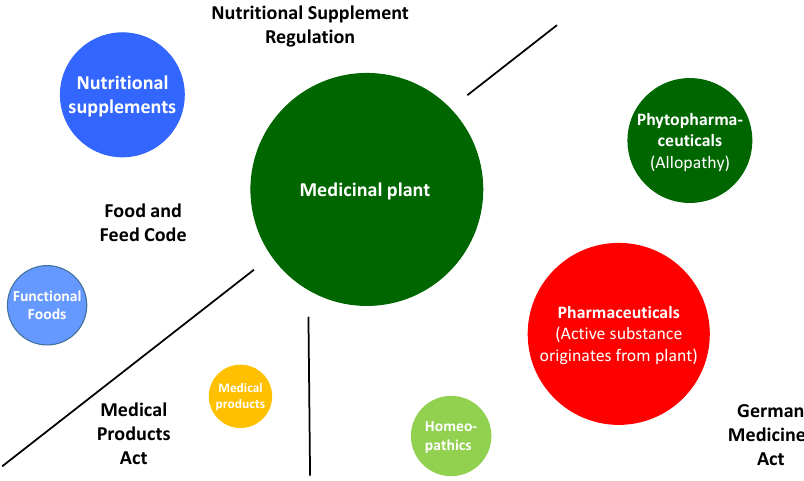
Figure 3. The use of plants from medicinal products to health products and the respective applicable legal norms in Germany.